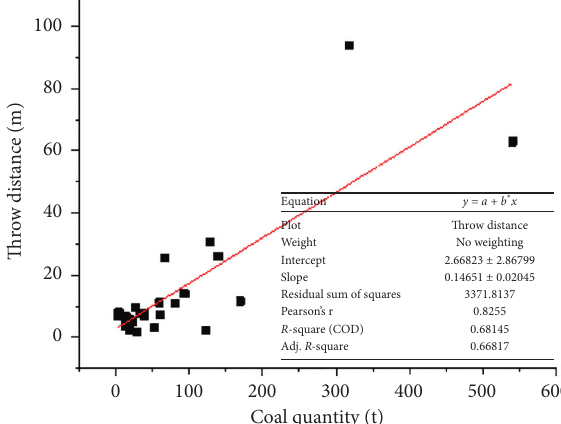
Figure 5: Linear correlation between CGO coal quantity and throw distance in 79 CGO